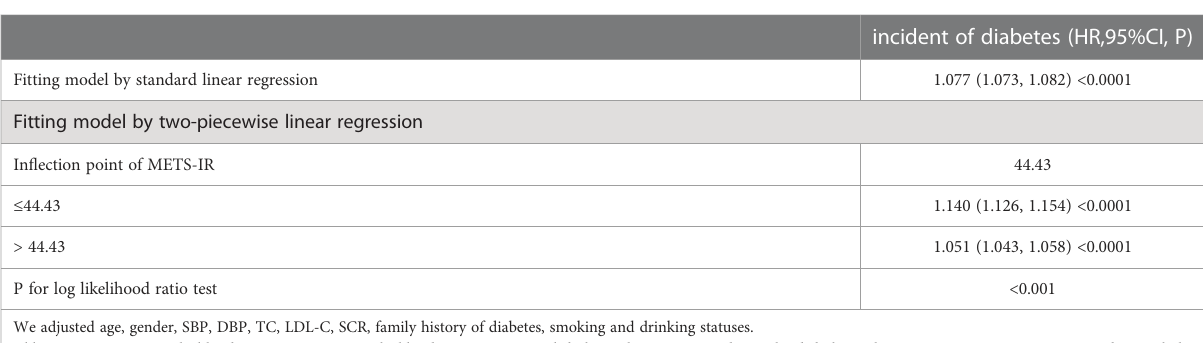
TABLE 4 The result of two-piecewise linear regression